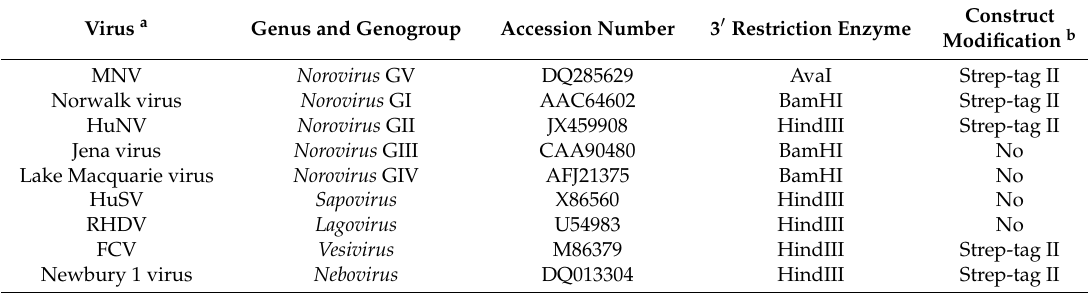
Table 1. Synthetic viral protein genome-linked (VPg) constructs to investigate the conservation of VPg-induced cell cycle